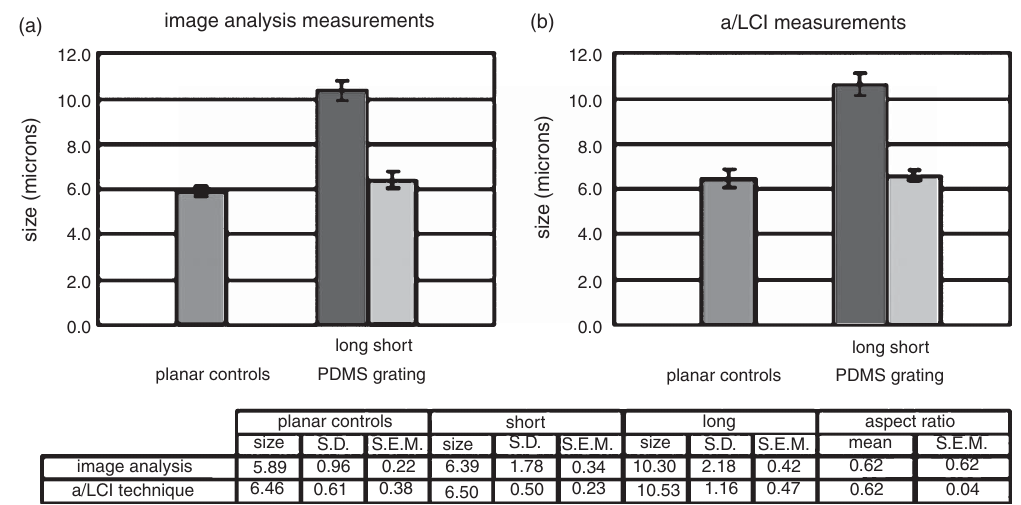
Fig. 11. a/LCI study of murine macrophage cell nuclei aligned due to nanopatterened substrates. Comparison with imaging analysis (a) shows high accuracy of nuclear morphology measurements using a/LCI technique (b). Nuclear elongation is statistically significant ( p <0.01) for both a/LCI and image analysis measurements. Taken from [39].